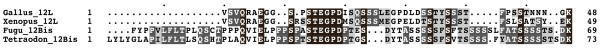
Amino acid alignment of CSTs found in intron 12. The Conserved Sequence Tag (CST) corresponds to an internal cassette exon (12Bis) in non-mammalian tetrapods and to a longest splicing isoform of exon 12 (12L) in pufferfishes. Identical, similar and conserved positions are indicated with different background.